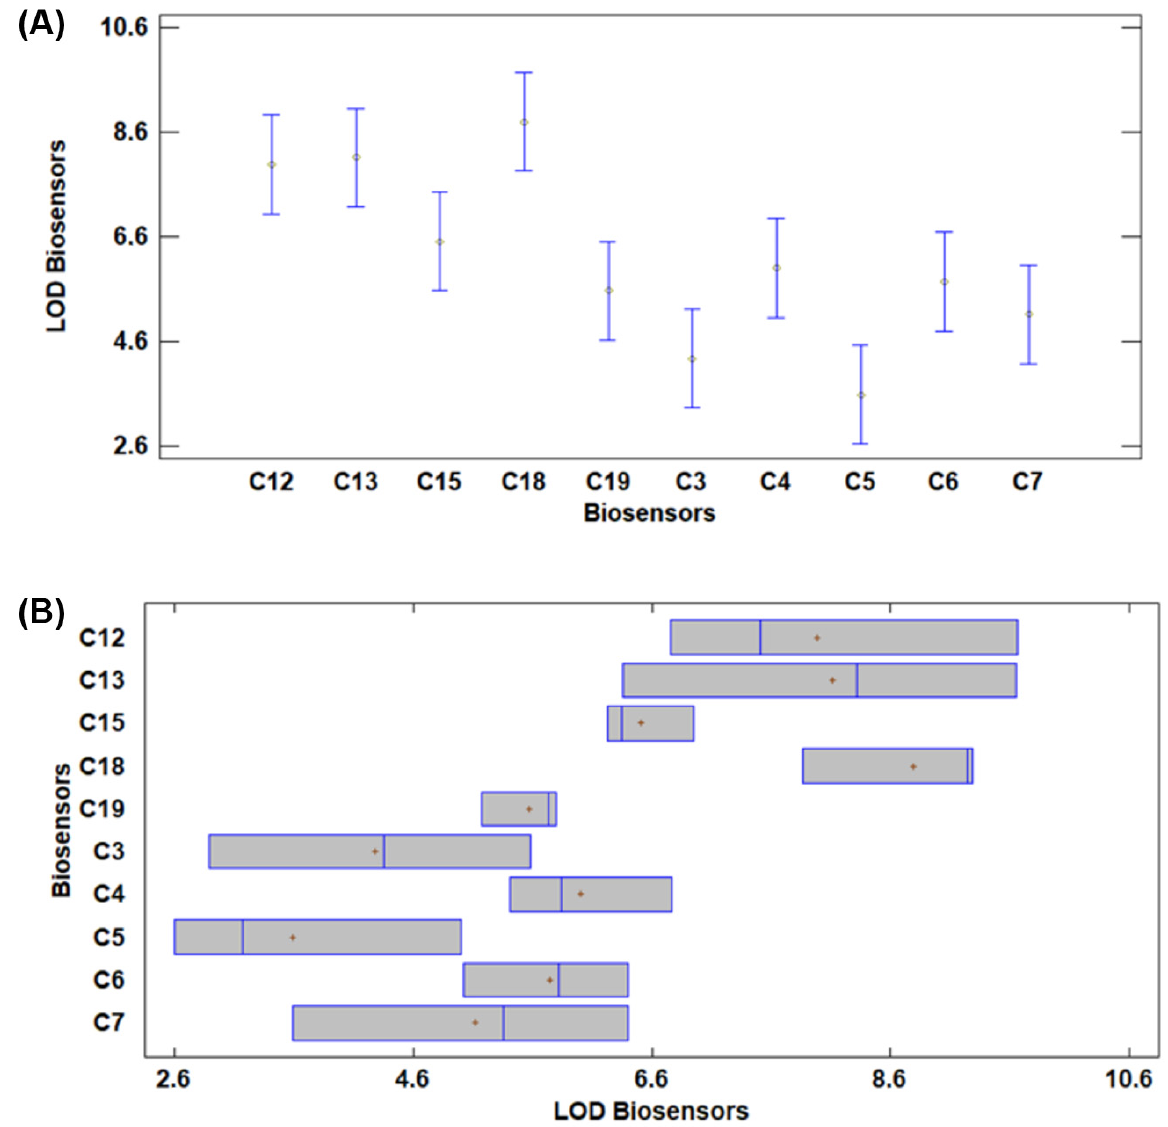
Figure 6. ANOVA graphs referred to the LOD (µM) and biosensors prepared, confidence intervals for the mean (Fisher Least significance difference): ( A ) mean graphs and ( B ) box and whisker plot. SNGC/PEDOT+Tyr-SV (C3), SNGC/AuNPs (drop)/PEDOT+Tyr-SV (C4), SNGC/PEDOT+Tyr-SV/AuNPs (drop) (C5), SNGC/AuNPs (Electrogen)/PEDOT+Tyr-SV (C6), SNGC/AuNPs (Electro-